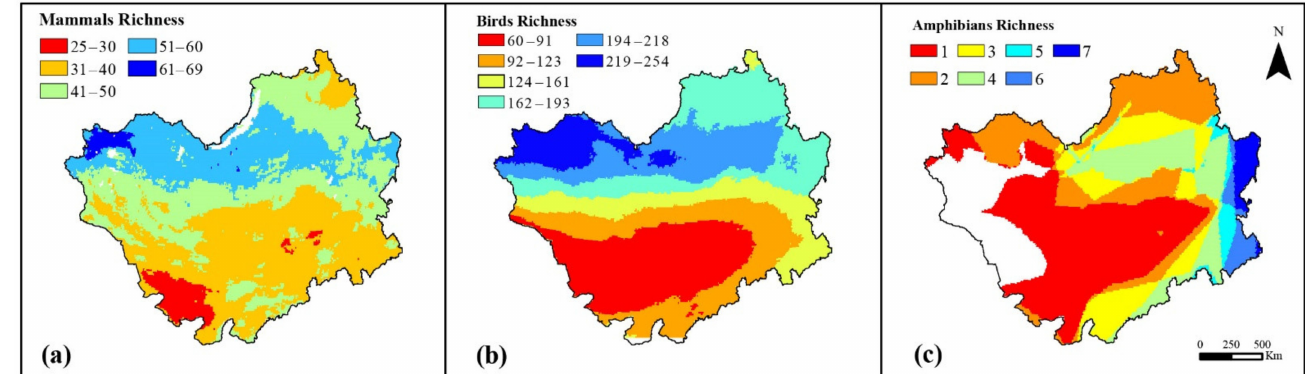
Figure 4. Distribution patterns of the species richness of different groups on the Mongolian Plateau: ( a ) mammal species richness, ( b ) bird, species richness, and ( c ) amphibian species